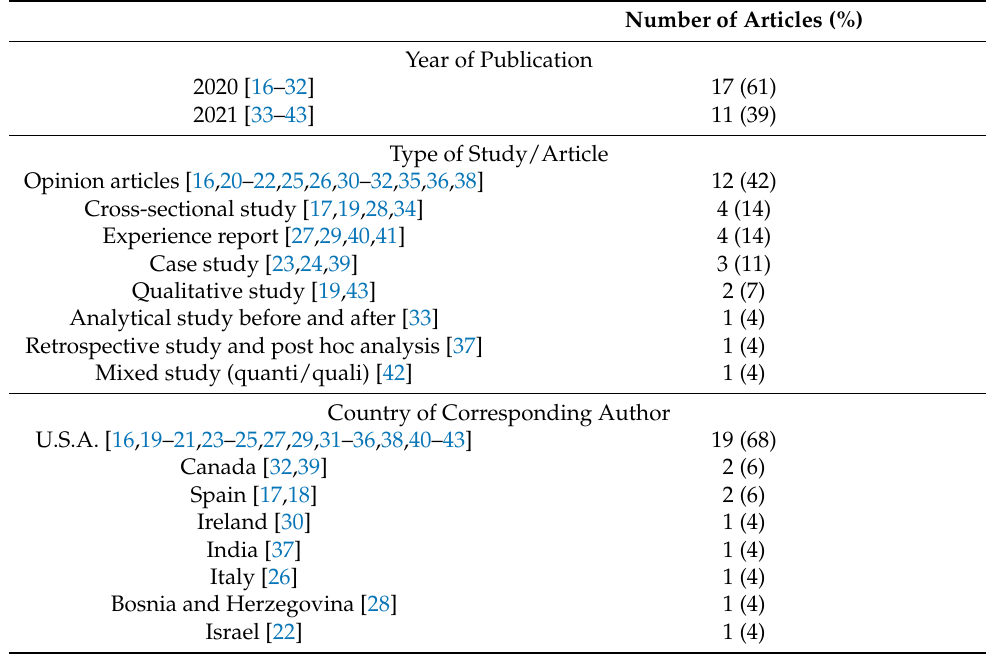
Figure 1. Preferred Reporting Items for Systematic Reviews and Meta-Analyses flowchart of the study identification, screening, and selection process. Table 1. Descriptive analysis of articles that propose strategies ( n =